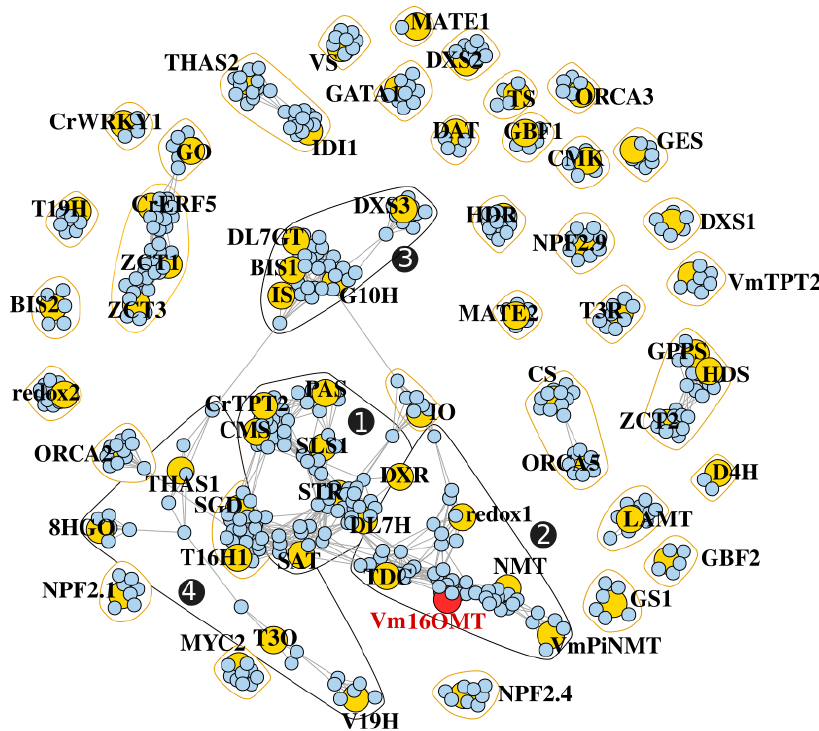
Figure 10. Co-expression network depicting the transcriptional relationship between annotated MIA genes (yellow) and V. minor transcripts (blue). Connected genes are indicated by grey edges for the retained HRR. Polygons correspond to communities detected using a fast greedy modularity optimization algorithm. The four main communities in the largest network are numbered with black circles and black polygons.